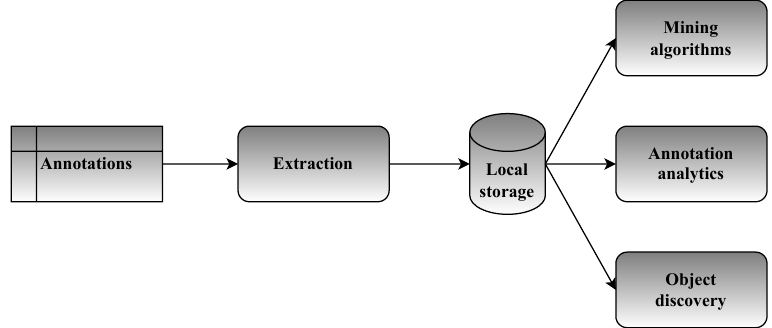
Figure 4. Annotations and the architecture of project ANTIKLEIA (Source: